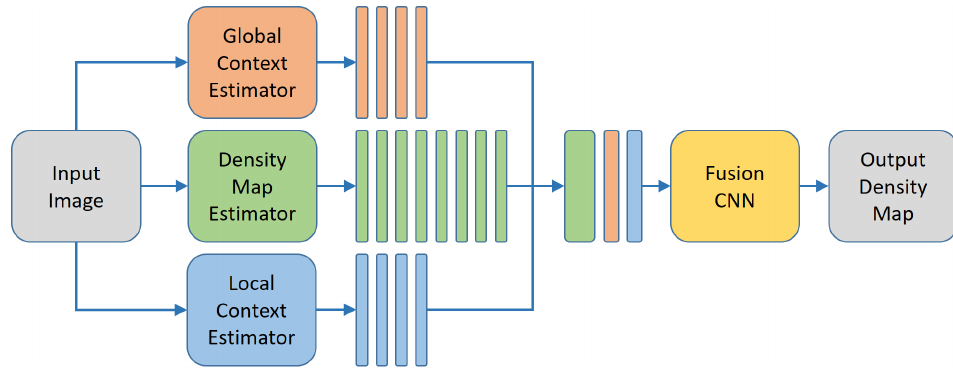
Figure 4. Contextual pyramid CNN for person counting